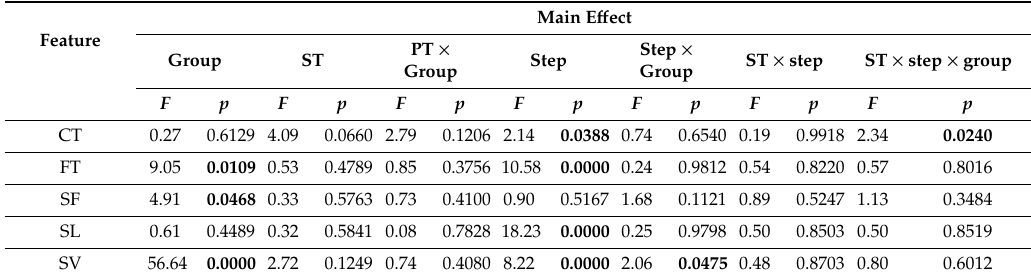
Figure 1. Sprint step kinematics characterizing the first nine steps (S) in the 20-m flying start sprint. Post-test variability in the sprint step characteristics was significant for group and step ( p < 0.05) (Table 5). The interactions ST × group, SL × group, ST × SL, and ST × SL × group did not show variability except SV and CT ( p < 0.05). Consequently, the consistent generation of high horizontal velocity in the run-up resulted in greater running velocity with stable SV when sprinting the 20 m distance. Table 5. ANOVA results of sprint step